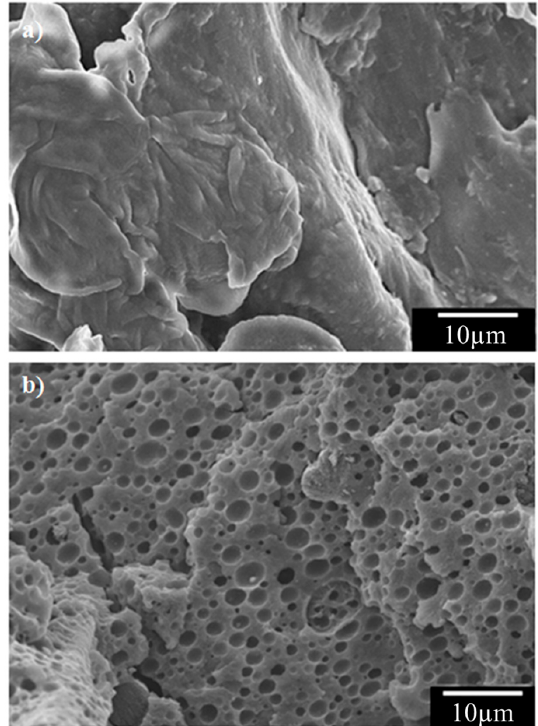
Figure 6. FE-SEM images of the fractured surfaces of CF-reinforced PA6/PP composites with ( a ) 0% PP and ( b ) 30% PP after etching PP by a xylene treatment.